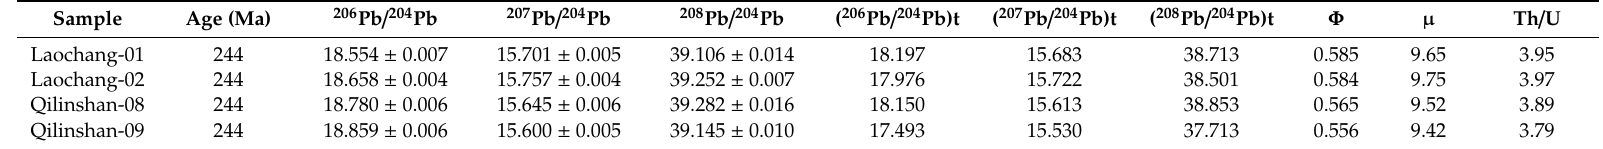
Table 3. Pb isotopic compositions of Qilinshan and Laochang